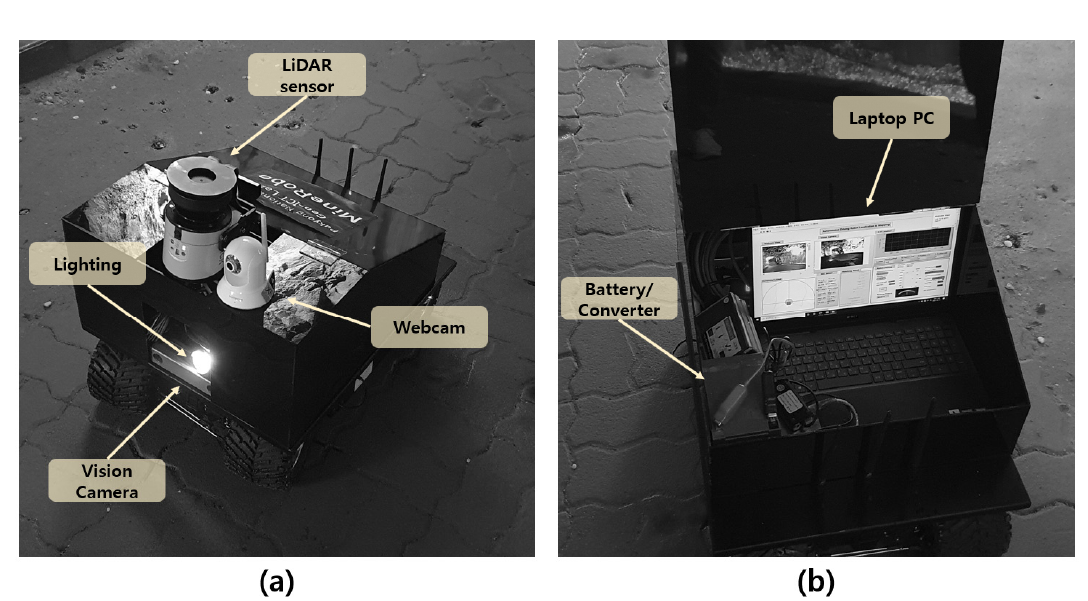
Figure 1. Autonomous driving robot and sensors used in this study: ( a ) external view, and ( b ) internal view.